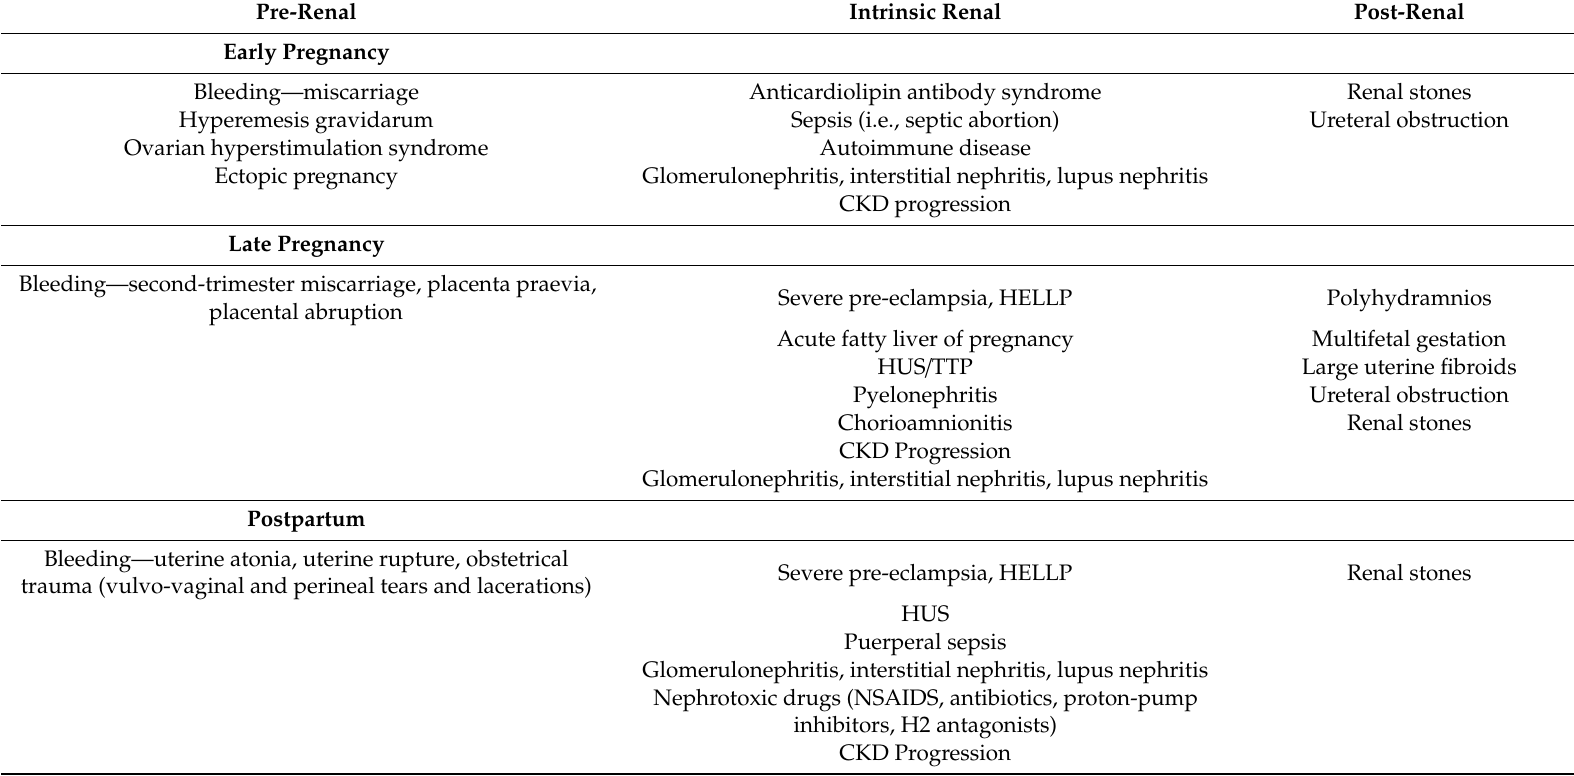
Table 5. Causes of acute kidney injury in pregnancy classified by the time of